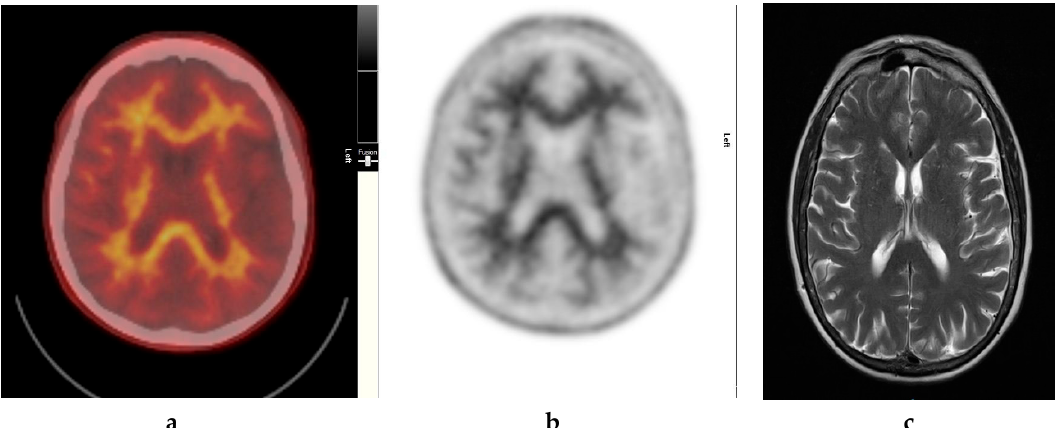
Figure 1. Normal study. Sixty-seven year old female patient with deteriorating cognition and multiple vascular risk factors for assessment for vascular dementia. ( a ) and ( b ) [18F]FBP shows good contrast between grey and white matter in all sections of the brain with no obvious evidence of beta amyloid plaque disease. This suggests that the diagnosis / development of Alzheimer’s disease is less likely. ( c ) MRI brain scan (multiplanar and multi sequence acquisitions) shows no significant T2 signal abnormality or restricted di ff usion to suggest space occupying lesion, infarction, or ischemic change. (figures are courtesy RLBUHT Hospital